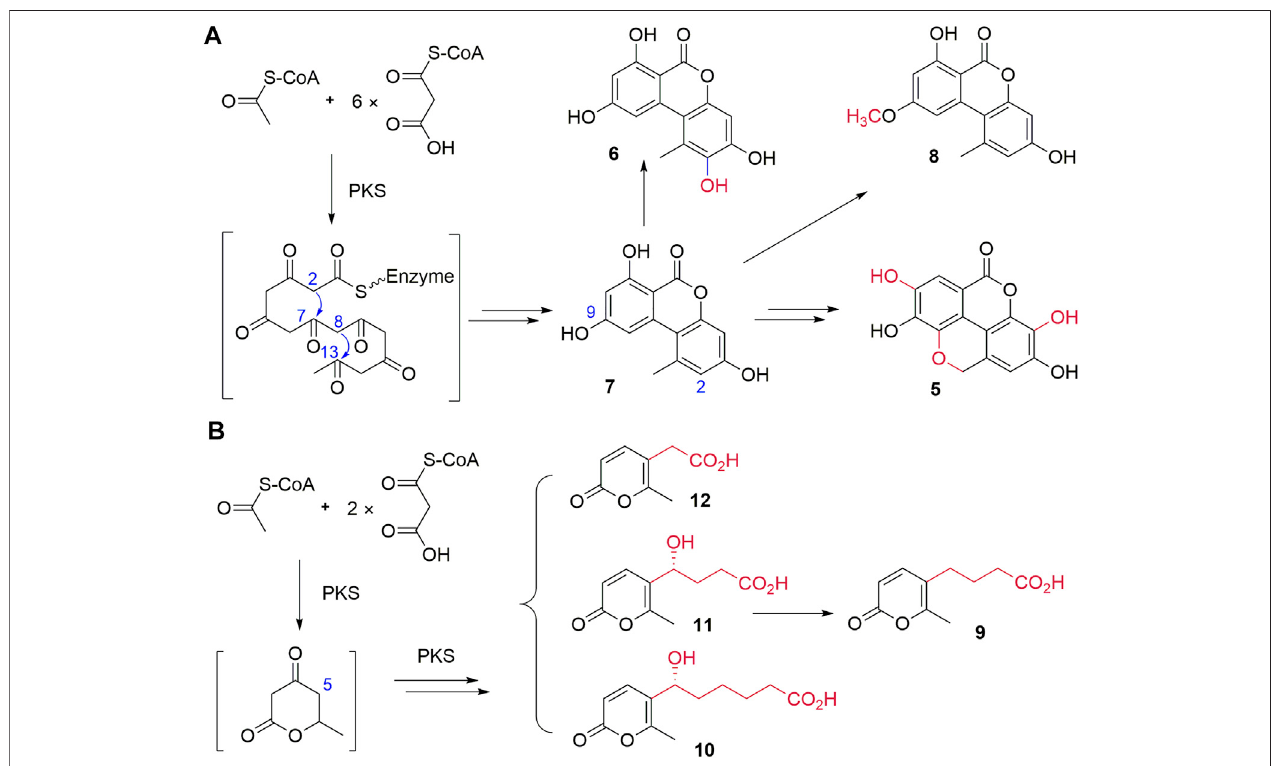
FIGURE 3 | Proposed biosynthetic pathways of 5 – 8 (A) and 9 – 12 (B) .